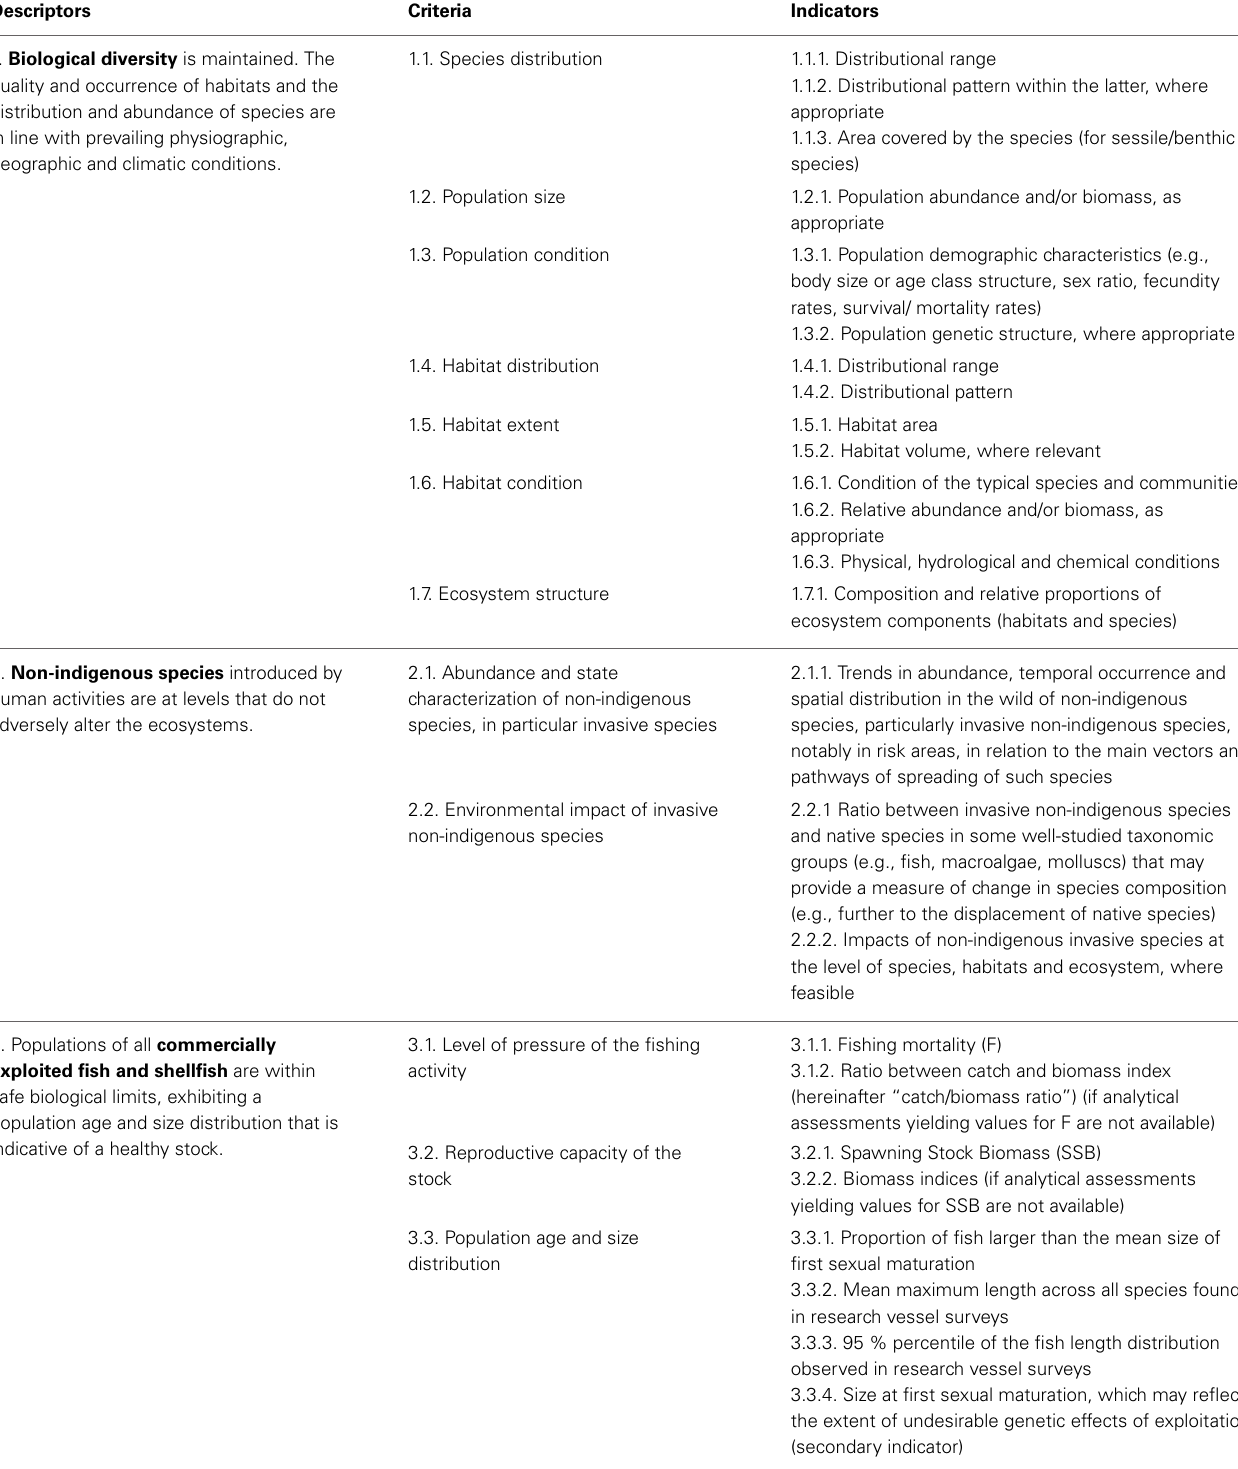
Table 1 | Descriptors, criteria and indicators selected by the European Commission (2010), for ecosystem-based assessment and management of European seas, within the Marine Strategy Framework